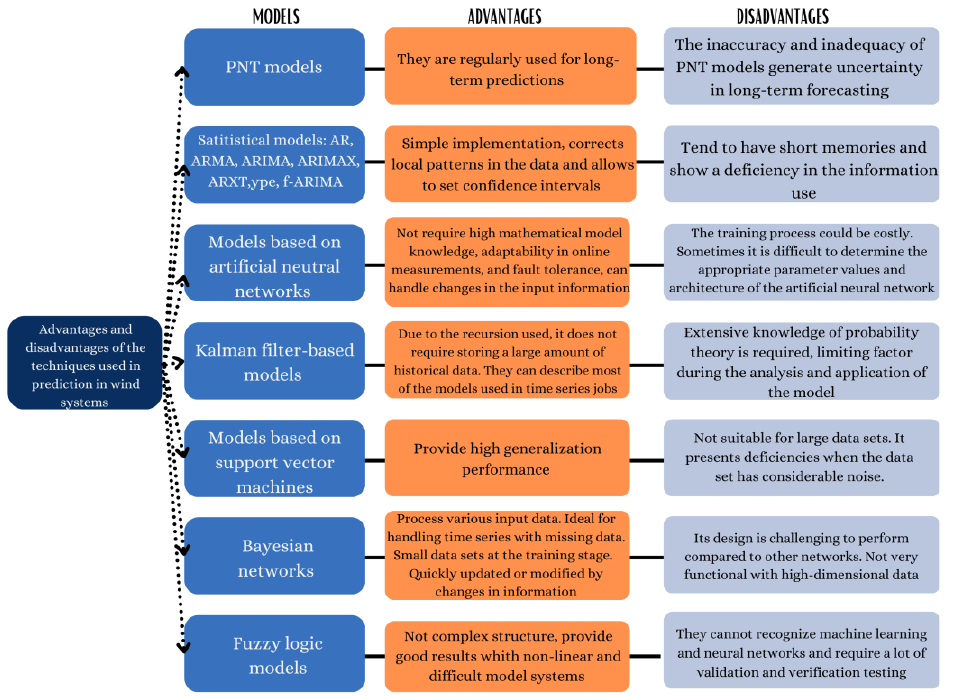
Figure 3. Classification of models used in wind forecasting, advantages, and disadvantages.